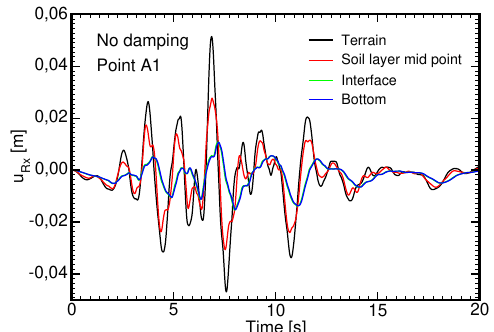
Figure 9. Time variation of horizontal displacement u Rx monitored at various points - QBB .